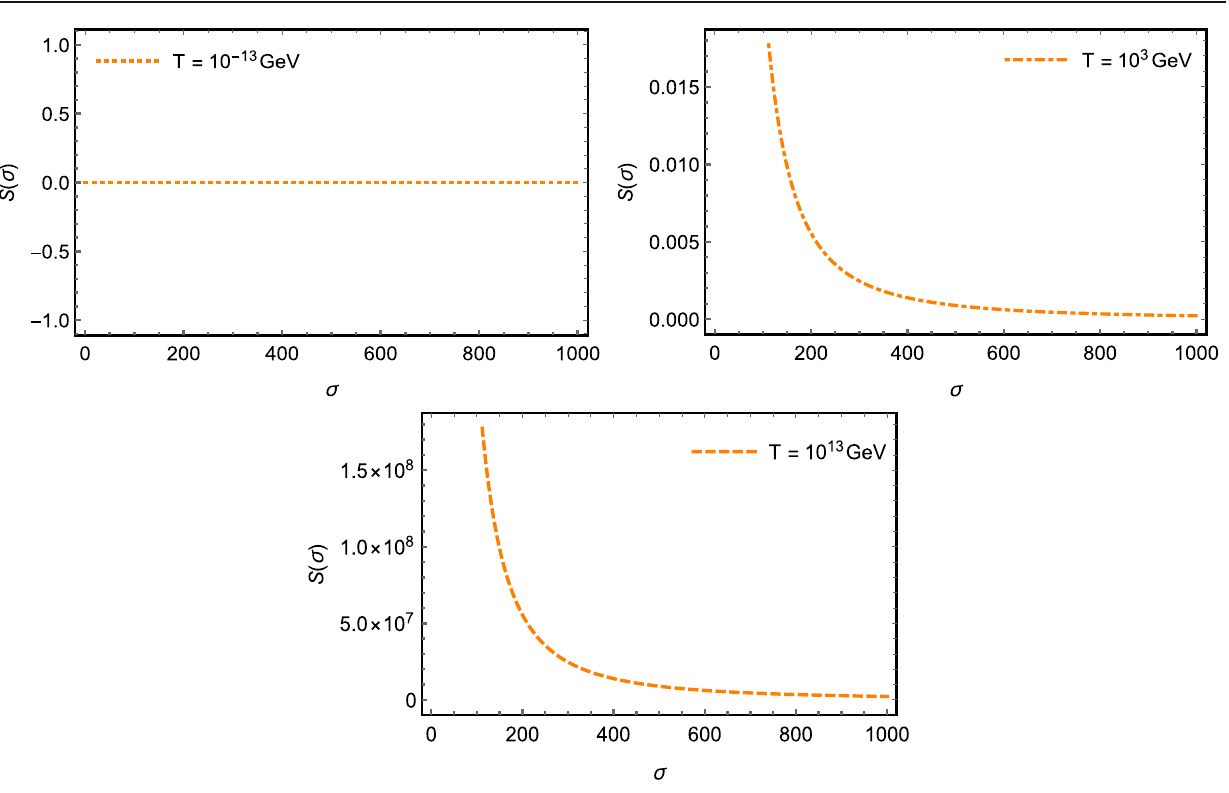
Fig. 6 The plots show the modification to the entropy S (σ) as a function of σ (its unit is GeV − 1 ) considering the temperatures of cosmic microwave background (top left), electroweak scenario (top right), and the early inflationary universe (bottom)